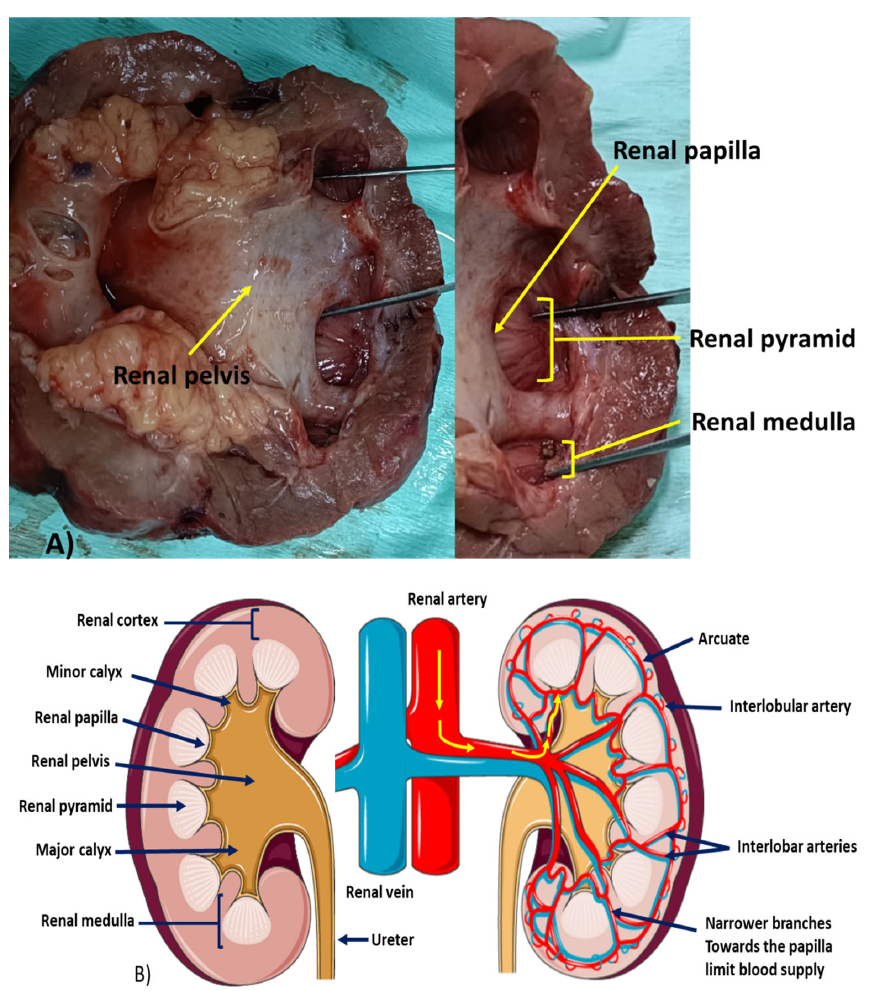
Figure 1. An illustration of renal papilla and fornix. ( A ) Depicts the position and structure of the renal papilla which lies within the renal medulla; and ( B ) the blood supply to the renal papilla showing that as the arteries narrow toward the papilla, the blood flow reduces predisposing the papilla to ischemia which could lead to necrosis. Blood is directly supplied to the renal papilla via the vasa recta which is the terminal artery of the renal artery, which branches into the lobar, interlobular, arcuate, and ulti ‐ mately the interlobular arteries. The interlobular arteries supply the glomeruli via the af ‐ ferent arterioles. The vasa recta branches into three terminal branches at the bottom of the medullary pyramid. The branches become narrower once the apex and papilla are reached. This limits the blood supply within the papillary tip, hence the risk for ischemia and, consequently, RPN is increased [21], Figure 1B. The loop of Henle is referred to as counter current multiplier and vasa recta as a counter current exchange system in concen ‐ trating and diluting urine, hence the increased risk of oxidative stress damage [22]. In the sagittal view, the kidney is divided into the outer cortex and the inner medulla. The for ‐ mer entails distal and proximal convoluted tubules, glomeruli, medulla rays, interlobular arteries, and veins. Each pyramid base is located next to the cortex and its apex forms the renal papilla that opens up into the minor calyx. A columnar epithelium covers the tip of the papilla merging into the transitional epithelium. The renal pedicle and branches; veins, arteries, and interlobular vessels are located within the renal sinuses. The interlobar